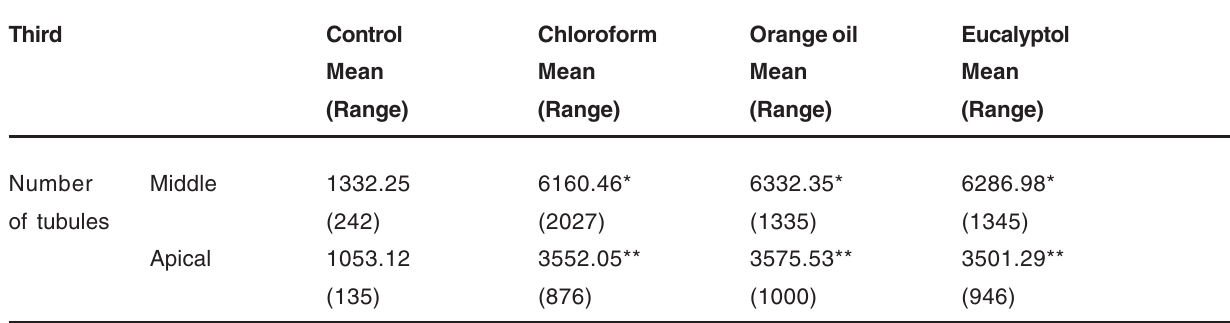
TABLE 1- Means of the number of dentinal tubules free of filling materials per mm 2 in each group